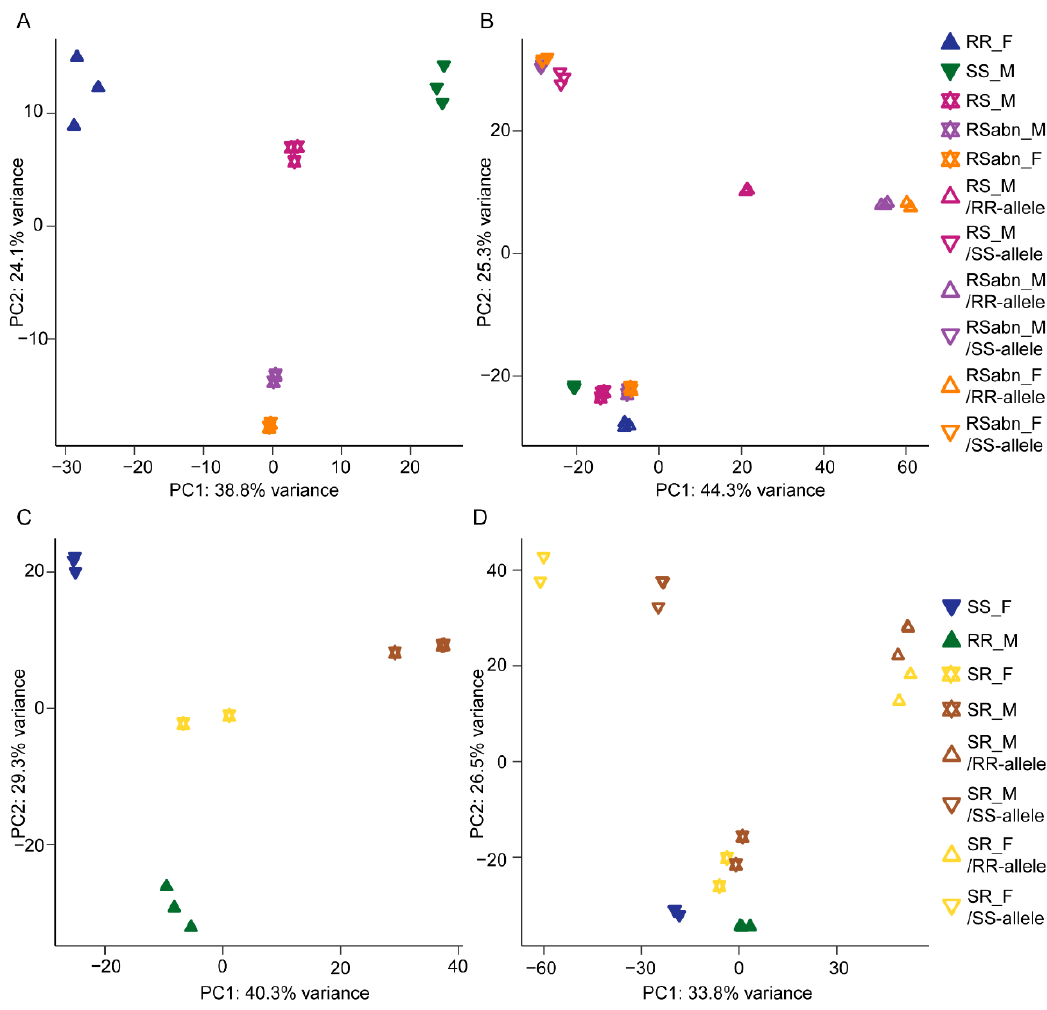
Figure 2. Principal component analysis (PCA) of the antennal transcriptome of H. armigera , H. assulta and their F 1 hybrids. ( A ) PCA of the antennal transcriptome of RR_F, SS_M and their F 1 hybrids. ( B ) PCA of the antennal transcriptome of RR_F, SS_M, their F 1 hybrids and alleles within F 1 hybrids. ( C ) PCA of the antennal transcriptome of SS_F, RR_M and their F 1 hybrids. ( D ) PCA of the antennal transcriptome of SS_F, RR_M, their F 1 hybrids and alleles within F 1 hybrids.